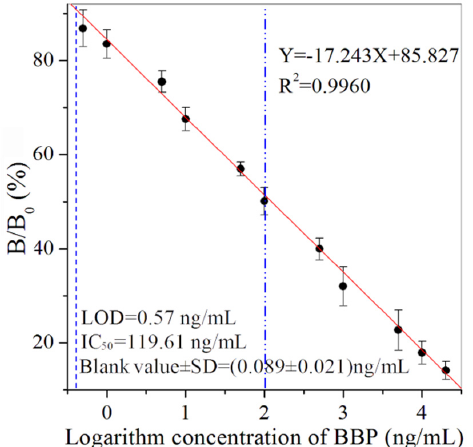
Figure 2. The standard curve of BBP by MBI ( n = 3).